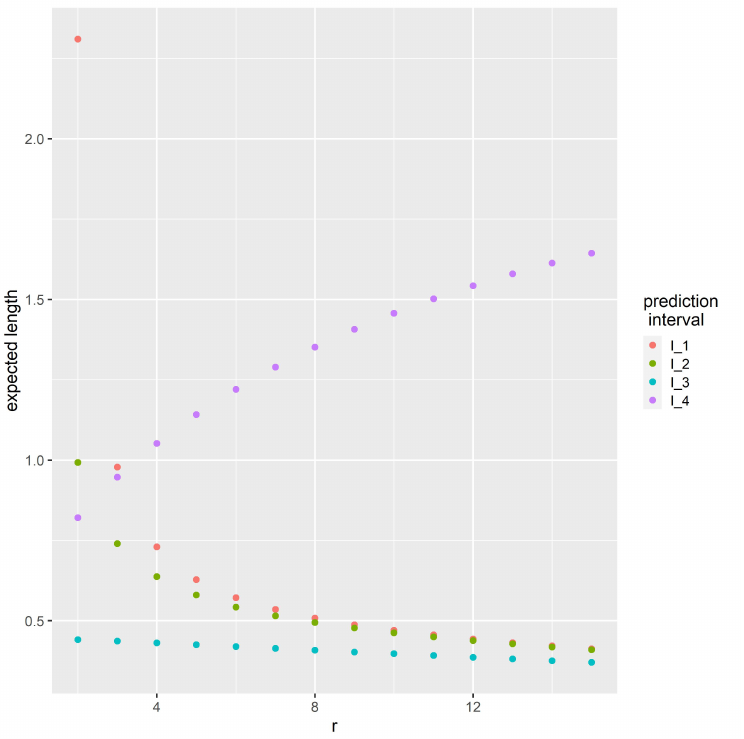
Figure 1. Expected lengths of the 90% prediction intervals I 1 , . . . , I 4 for the next lower record value ( s = r + 1) based on the first r lower record values from a Pow ( λ , β ) distribution with λ = 11.3 and β =